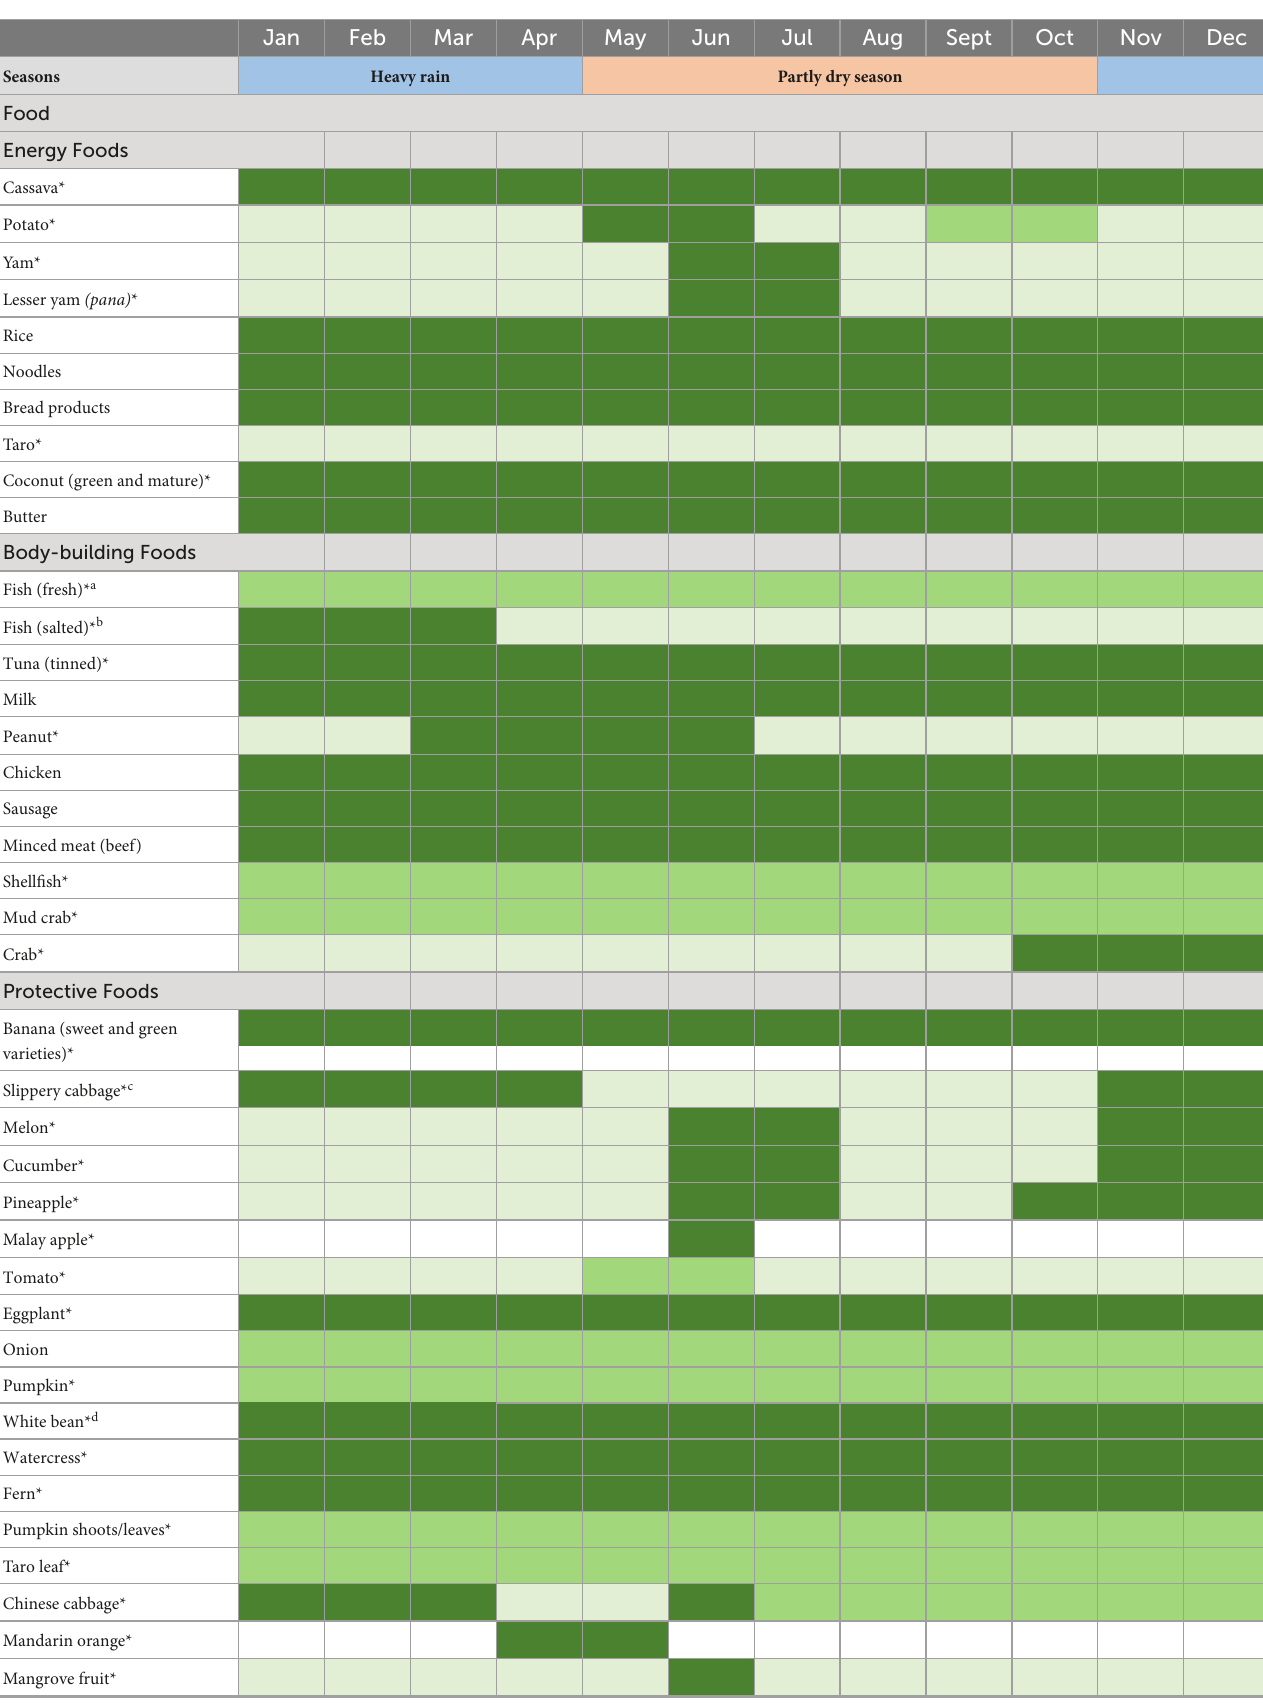
TABLE 4 Seasonal food availability calendar for Kola’a (urban